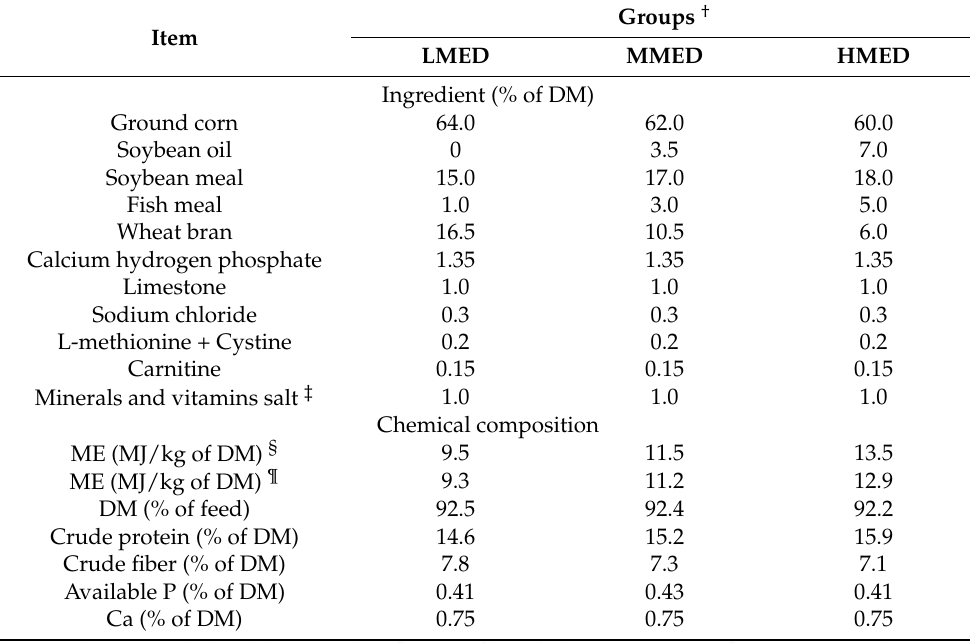
Table 1. Ingredients and chemical compositions of 3 diets for supplementing grazing Swan